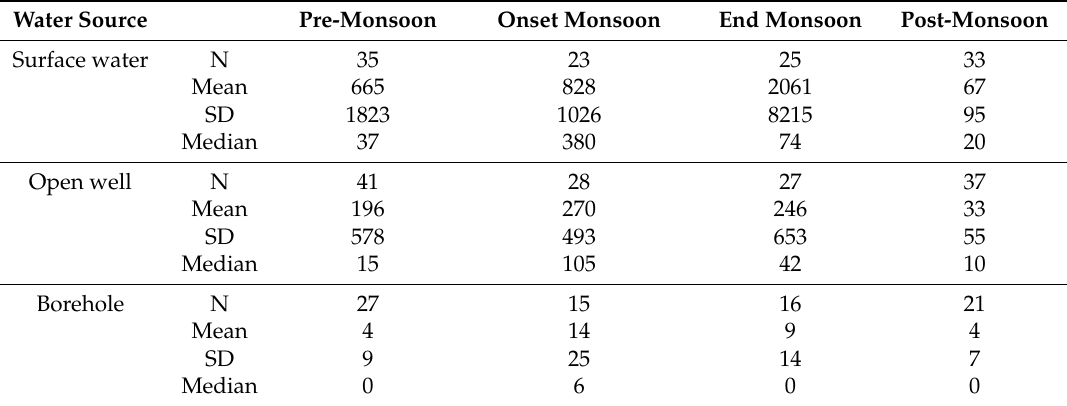
Table 1. Fecal coliforms (FC) concentrations in different water sources through different seasons. Water